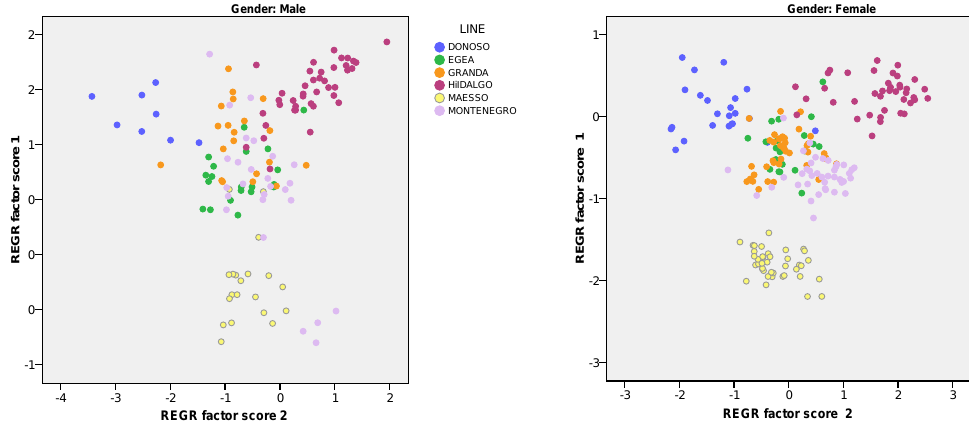
Figure 1. Scatter plot of the principal component analysis (Factor 1 vs. Factor 2), for females and males.